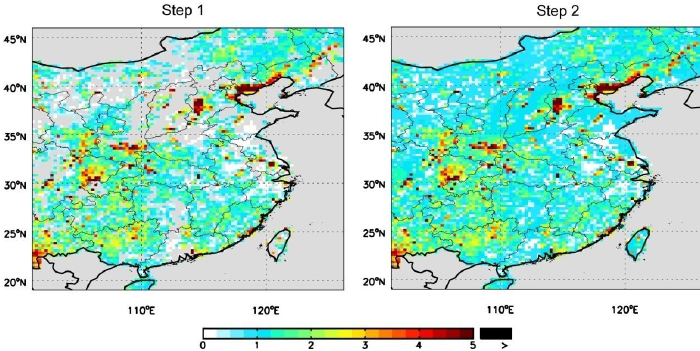
Fig. 8. Scaling factors for lightning/soil emissions ( k l ) determined at steps 1 and 2 of the inversion process described in Fig. 6 and Sect. 4.1.2. These two steps decide k l for all gridboxes. Areas outside the territory of China or with undetermined k l are shown in